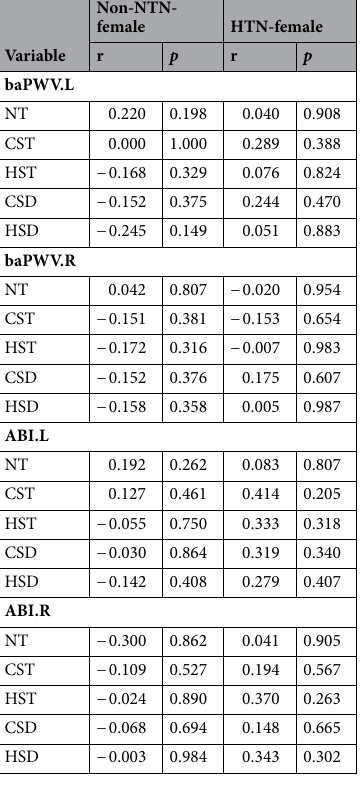
Table 5. Correlation analysis between female microvessel area and arterial stiffness.